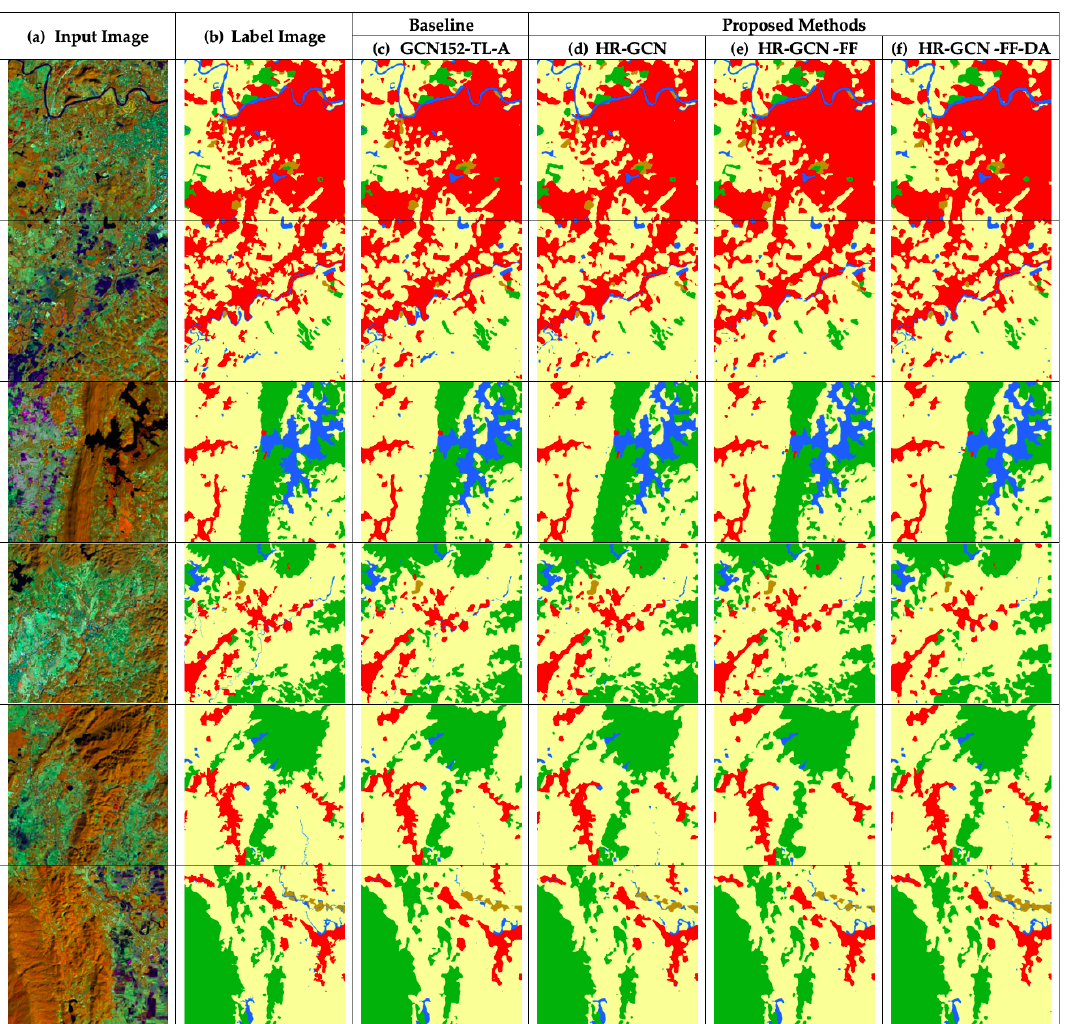
Figure 14. Comparisons between “HR-GCN-FF-DA” and beyond baseline methods on the Landsat-8w5c corpus testing